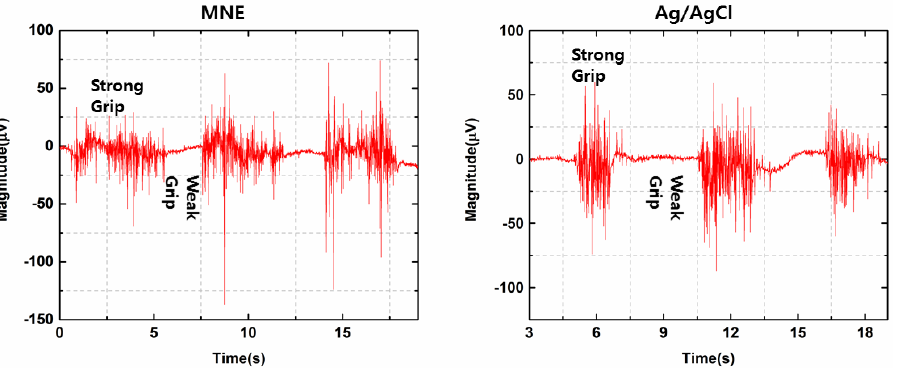
Figure 5. Comparison of MNE and Ag/AgCl electrode performance for EMG signal monitoring during strong and weak grip actions.